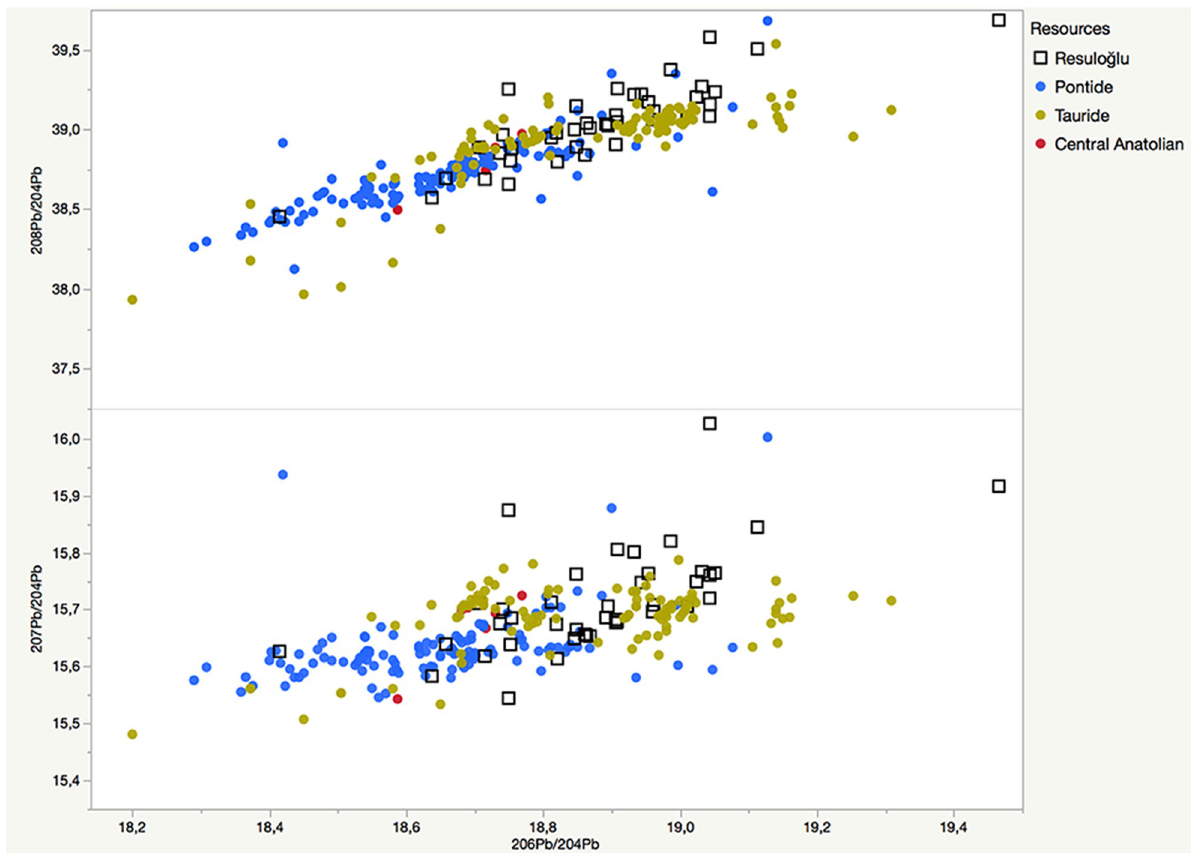
Fig 12. Lead isotope ratio binary graphs displaying 206 Pb/ 204 Pb vs. 207 Pb/ 204 Pb and 208 Pb/ 204 Pb of analyzed Resulo ğ lu metal samples compared to the published ore data from the Tauride and Pontide, and central Anatolia.